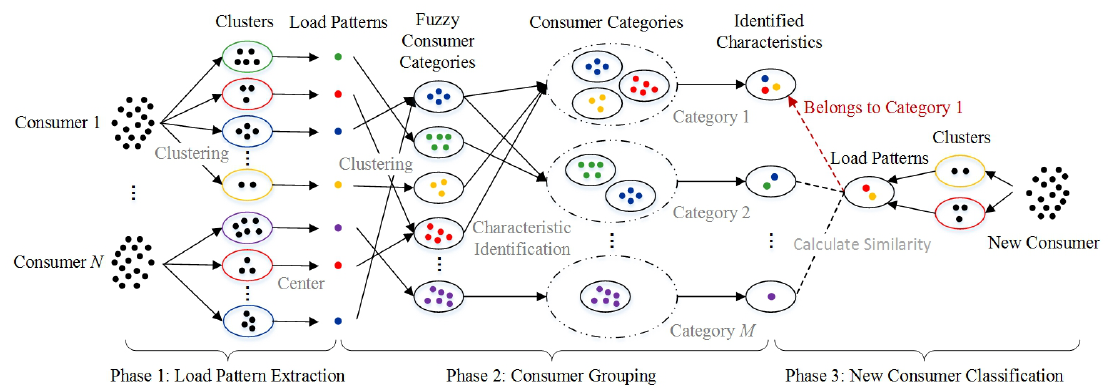
Figure 3. The diagram of new consumer classification. Every spot stands for one daily load curve or load pattern. When a new consumer comes (at right), we calculate the similarity between the load patterns of the consumer and each identified characteristic based on Equations (1)–(3). The consumer belongs to the consumer category with the smallest similarity value. Here, the new consumer belongs to Category